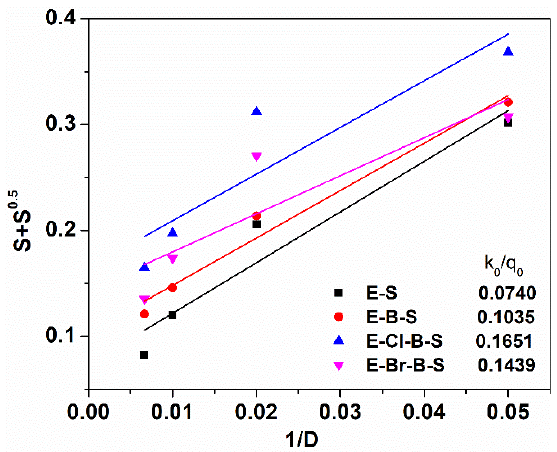
Figure 7. Charlesby–Pinner plots for EPDM composites at different irradiation doses.